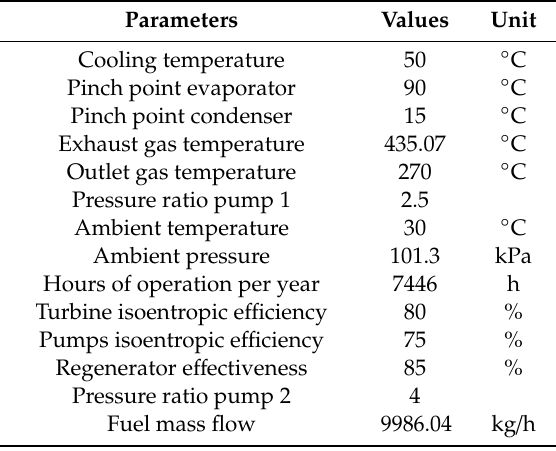
Table 5. Base condition parameters for a RORC